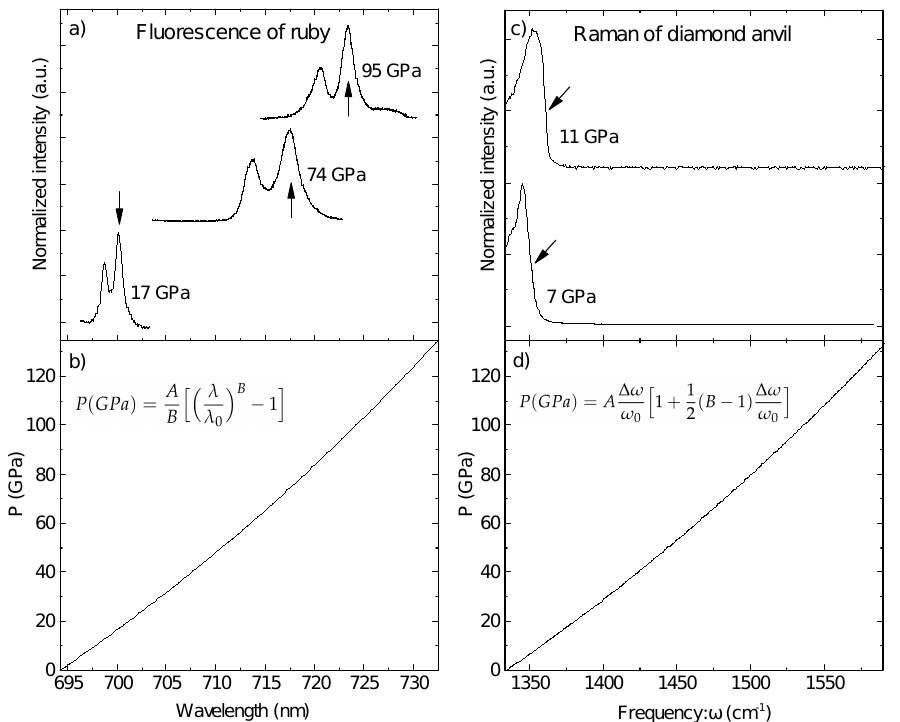
Figure 7. Left panel: ( a ) Ruby fluorescence signals at different pressures. The arrows indicate the position of the more intense peak, where the calibration is taken. ( b ) Pressure vs. wavelength relation according to the most recent calibration by Liu et al. [139]. The relation is obtained through the equation here represented, where λ is taken as indicated in panel ( a ) and λ 0 = 694.24 nm. According to the calibration A = 1904 GPa and B = 9.827 [139]. Right panel: ( c ) Raman spectra of diamond anvils at different pressures. The arrows indicate where the calibration is taken. ( d ) Pressure vs. frequency relation according to the most recent calibration by Akahama and Kawamura [147]. The relation is obtained following the equation represented, where ∆ ω = ω − ω 0 , ω is the wavelength taken at the edge of the signal as indicated by the arrows in panel ( c ) and ω 0 = 1334 cm − 1 . In the chosen calibration A = 547 GPa and B = 3.75